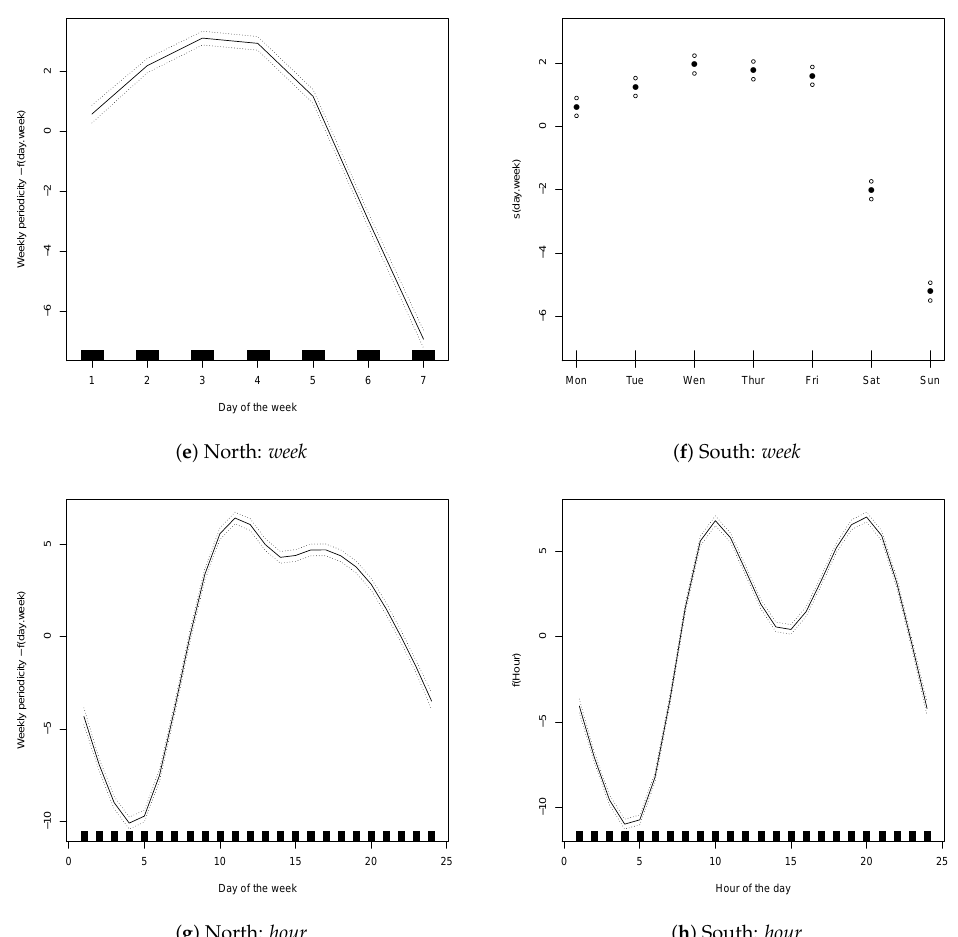
Figure 2. In-sample estimation results of the non-parametric additive model for the conditional mean of electricity prices. For both zones, each panel plots the estimated function f j ( · ) for the calendar effects and the overall trend.